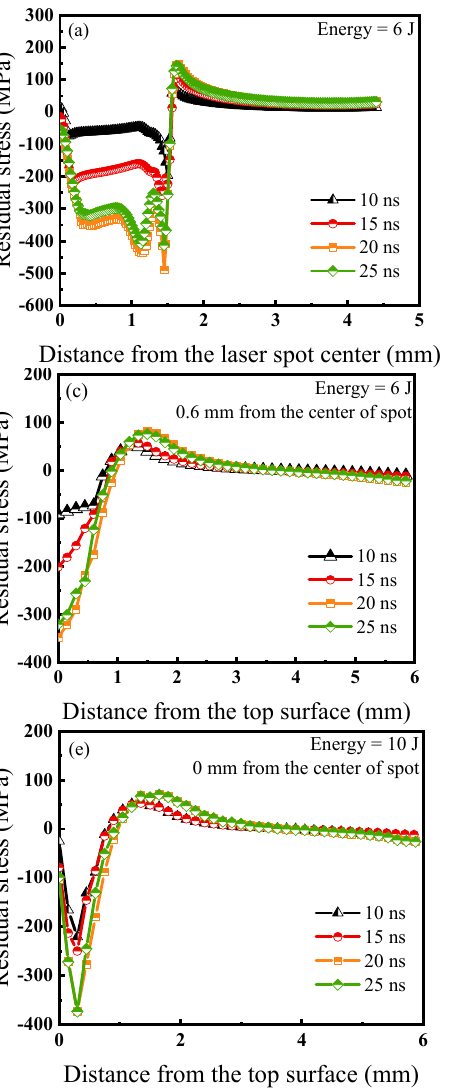
Figure 7. Residual stress distribution of samples with different pulse widths ( a ) Pulse energy 6 J: surface residual stress ( b ) Pulse energy 6 J: residual stress in the depth direction of the spot center ( c ) Pulse energy 6 J: residual stress at a depth of 0.6 mm from the spot center ( d ) Pulse energy 10 J: surface residual stress ( e ) Pulse energy 10 J: residual stress in the depth direction of the spot center ( f ) Pulse energy 10 J: residual stress at a depth of 0.6 mm from the spot center.